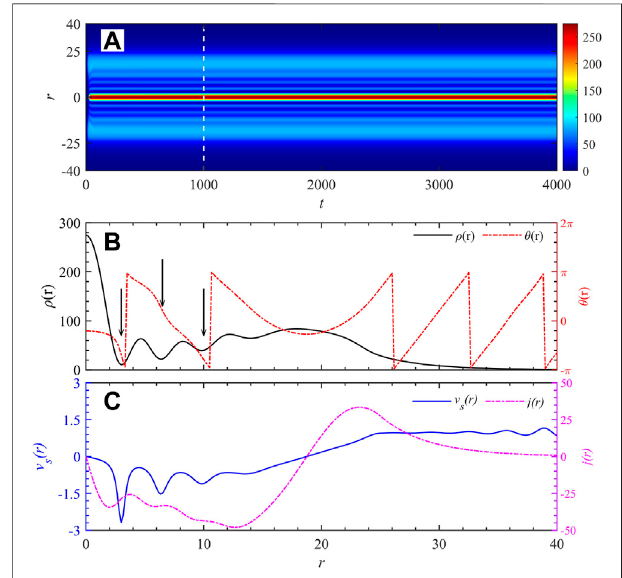
FIGURE 6 | (Color online) (A) Radial evolution of polaritons density (cid:3)(cid:3)(cid:3)(cid:3) (cid:3)(cid:3)(cid:3)(cid:3) 2 described by Eq. 1 with pumping radius R (cid:2) 25 and decay ratio φ ( r , t ) c / c (cid:2) 0 . 1, corresponding to location marked by pentangle in Figure 1 . (B) c R Radial distribution of polaritons density ρ ( r ) and phase θ ( r ) at t (cid:2) 1000. (C) Radial super fl uid velocity v s ( r ) and polaritons current j ( r )